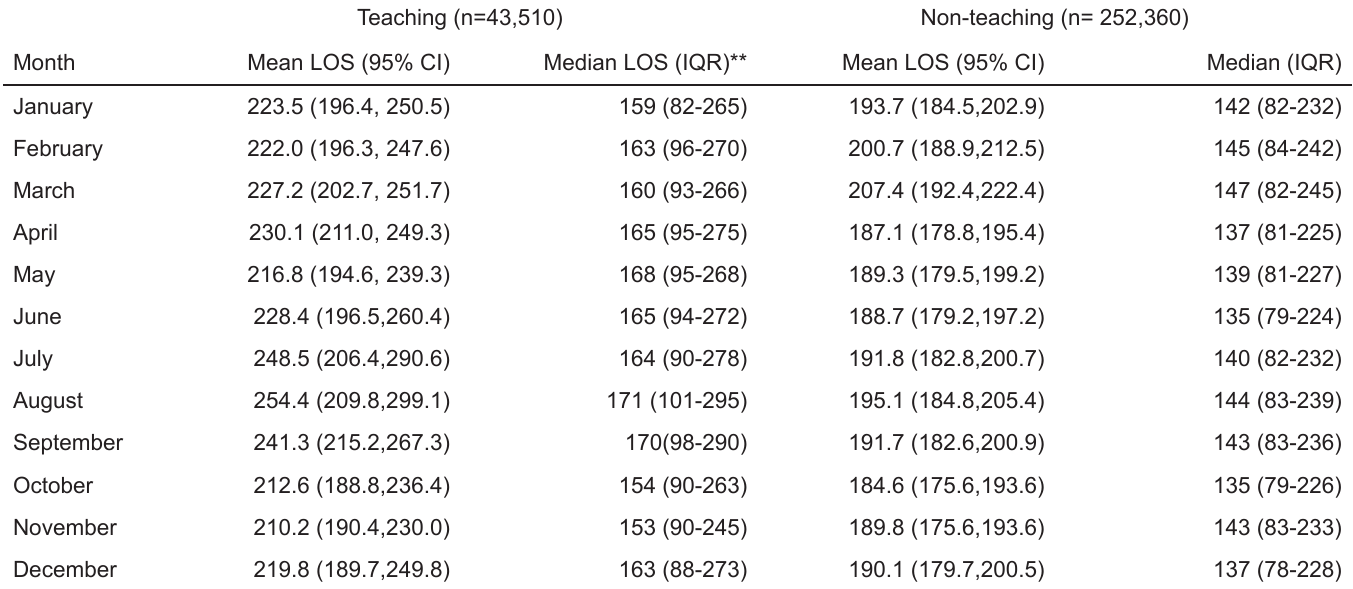
Table 1. Length of stay (LOS) in minutes in teaching* and non-teaching hospitals by month, emergency department NHAMCS (N= 262,382), 2001-2009.